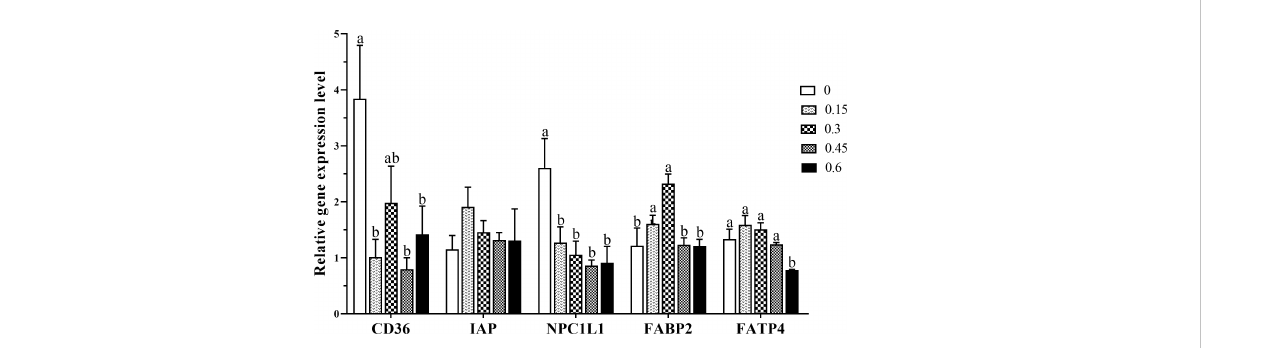
FIGURE 3 Gene expression levels of fatty acid transporters in the intestine of coral trout responded to the different dietary bile acids levels. Values are expressed as mean ± S.E.M (n=6). Different letters indicate signi fi cant differences among groups ( P < 0.05). IAP, alkaline phosphatase; NPC1L1, NPC1 like intracellular cholesterol transporter 1; FABP2, fatty acid binding protein 2; FATP4, Fatty acid transport protein 4.